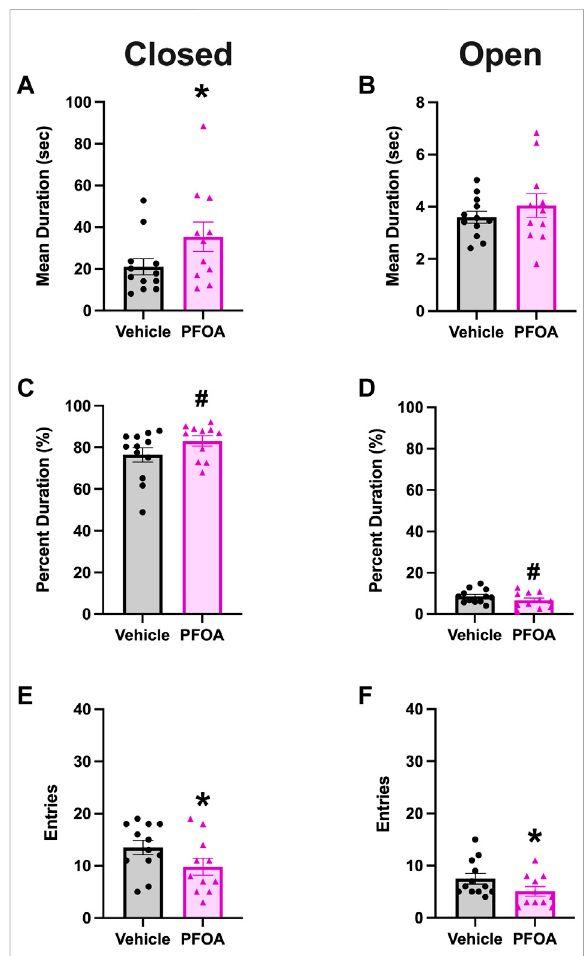
FIGURE 5 Elevated Plus Maze. PFOA dams had a signi fi cantly higher mean duration (A) and a marginally non-signi fi cantly elevated percent duration (C) in the closed arms. Additionally, PFOA dams had a marginally non-signi fi cantly decrease in the percent duration (D) spent in the open arms. Furthermore, the number of entries into both the closed arms (E) and open arms (F) were signi fi cantlyreducedinPFOAdams.Therewasnodifferenceinthe mean duration (B) spent in the open arms. Data shown as mean ± standard error of the mean, n = 11/PFOA and n = 12/vehicle. Data analyzed with one-sided student ’ s t-test. Asterisks means p ≤ 0.05 and number sign means p ≤